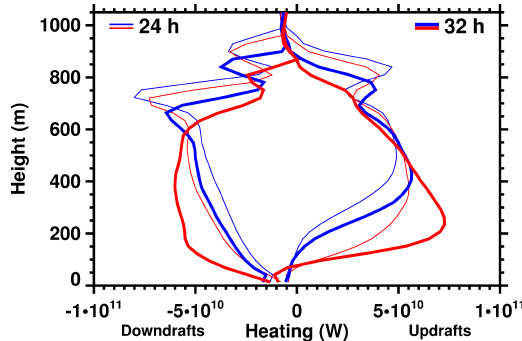
Fig. 15. Total heating (latent + long-wave) in downdrafts (left) and updrafts (right), after 24h (thin curves) and 32h (thick curves) in simulation S ◦ (blue) and S ⊗